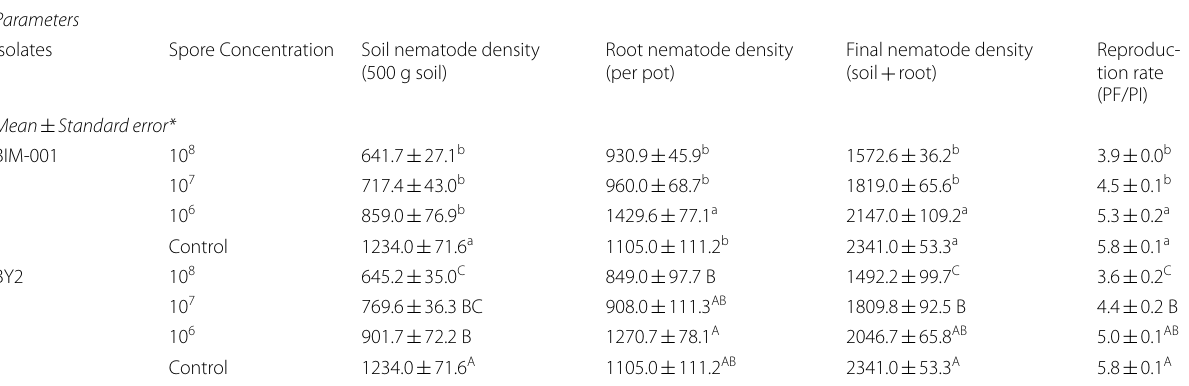
Different lowercase letters in the same column indicate significantly different means for isolate BIM-001, while uppercase letters in the same column indicate significantly different means for isolate BY2 (